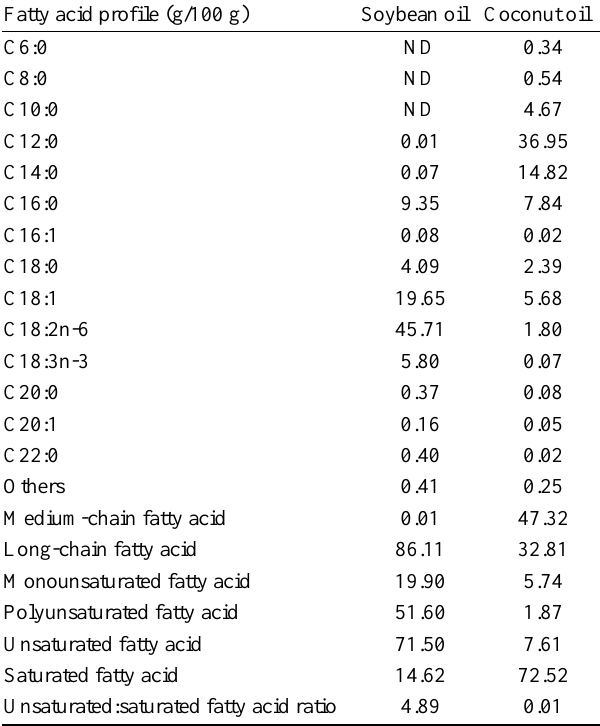
Table 2. Fatty acid composition of soybean oil and coconut oil 1 Fatty acid profile (g/100 g)